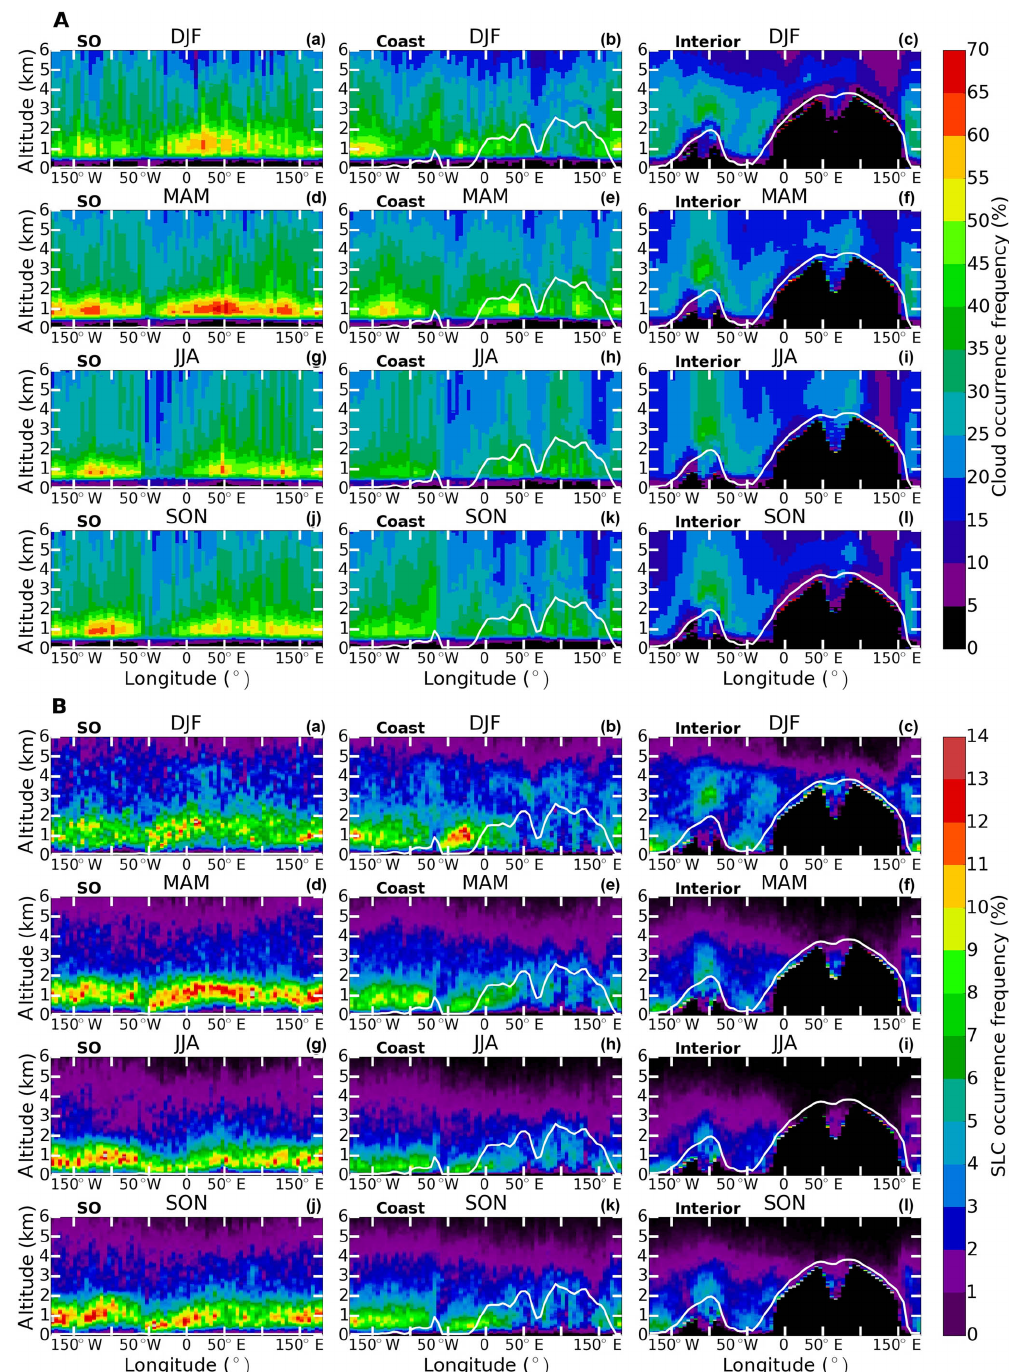
Figure 7. (A) Four-year (2007–2010) average seasonal vertical transects of the cloud fraction, spatially averaged over three latitudinal bands defined in Fig. 4d (SO stands for Southern Ocean). One column corresponds to one latitudinal band, showing the four seasons. Each line corresponds to one season. (B) Same as (A) for the SLC fraction. The white line is the average surface elevation in the latitudinal band.